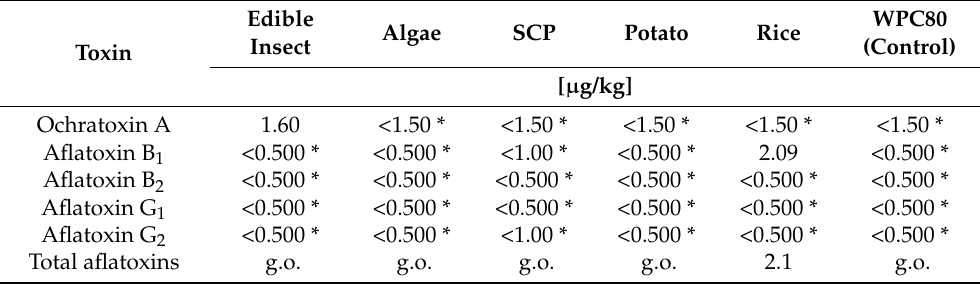
Table 5. Mycotoxin content in alternative and unconventional protein sources compared to the whey protein concentrate (WPC80—control sample). Edible Toxin